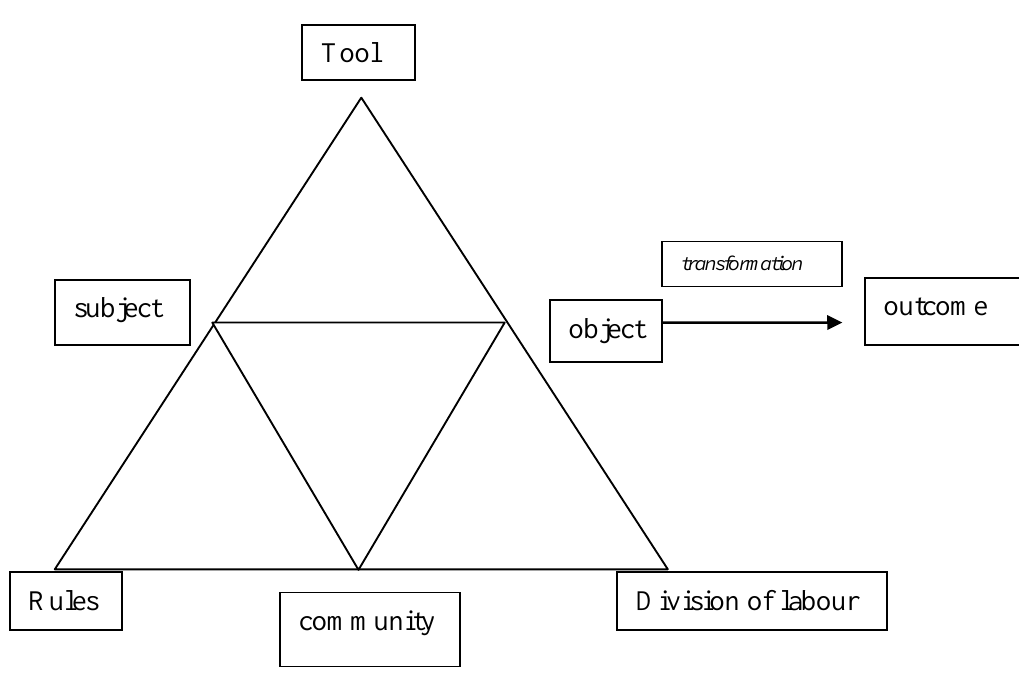
Figure 1 . Standard representation of the activity theory